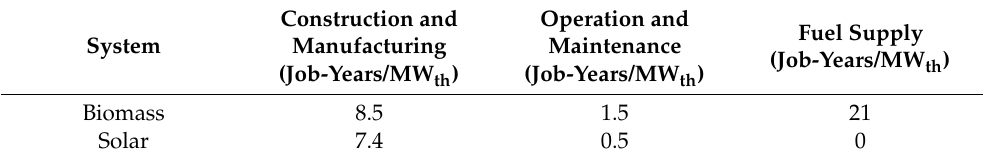
Table 5. Estimated ratios by type of job-years per modular hybrid system [25,26,64].